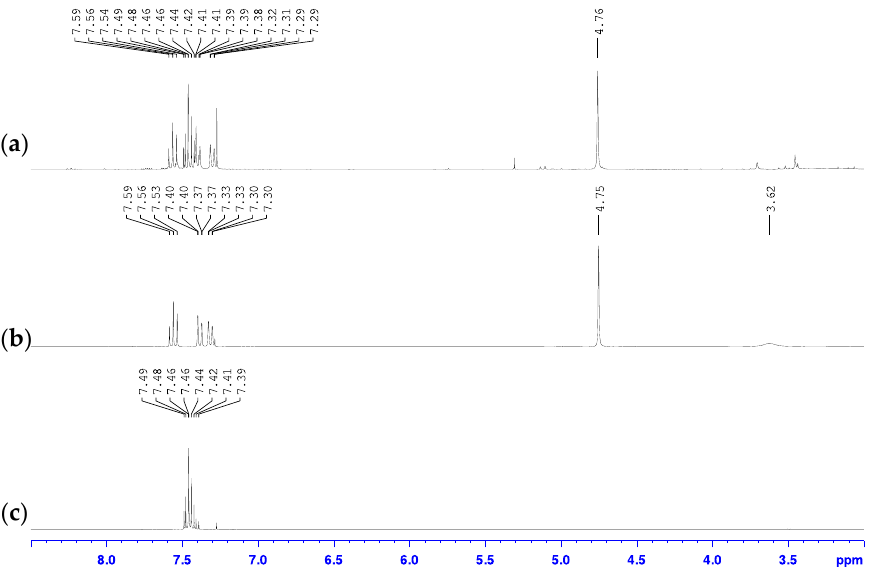
Figure 2. Overlay of the 1 H-NMR spectra of ( a ) oil mixture with solid, ( b ) pure oil, and ( c ) pure 2,6-dibromopyridine starting material in CDCl 3 .